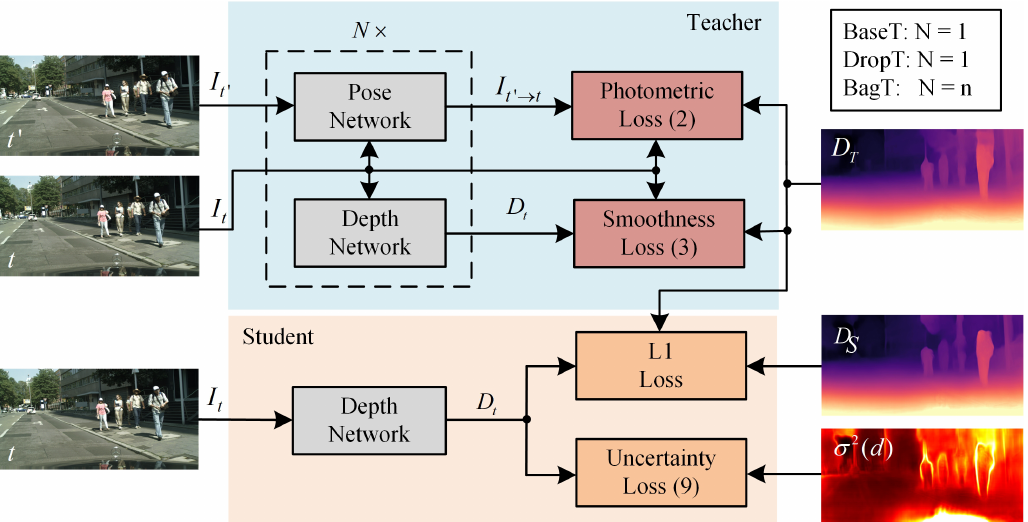
Figure 2. Overview of our proposed framework for joint uncertainty and depth prediction. The blue background corre- sponds to teacher network, and the gray blocks indicate encoders and decoders. The value of N in figure indicates the number of depth and pose networks taking the value of 1 for baseline or dropout as the teacher network, and N for bagging as the number of sub-networks. The light orange background corresponds to the student network. The red and orange blocks are the loss functions used, and the numbers inside represent the corresponding